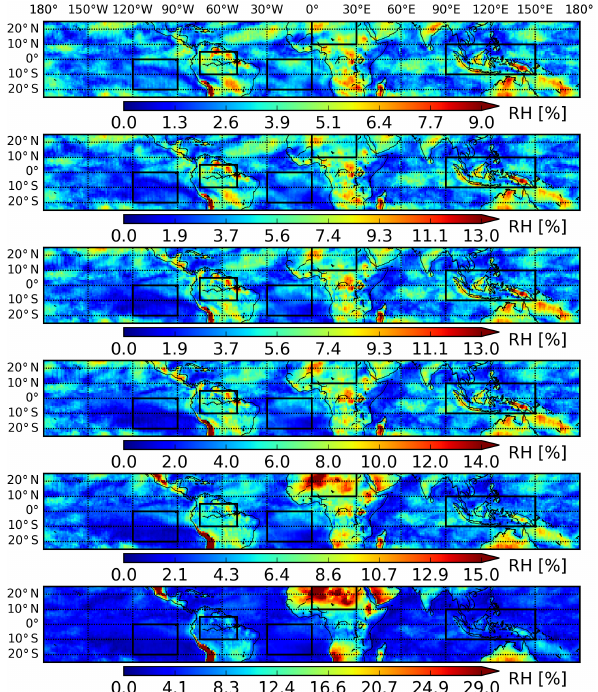
Figure 10. Spatial distribution of diurnal amplitude of RH I . Depicts from top to bottom are for SAPHIR channels 1–6, respectively.